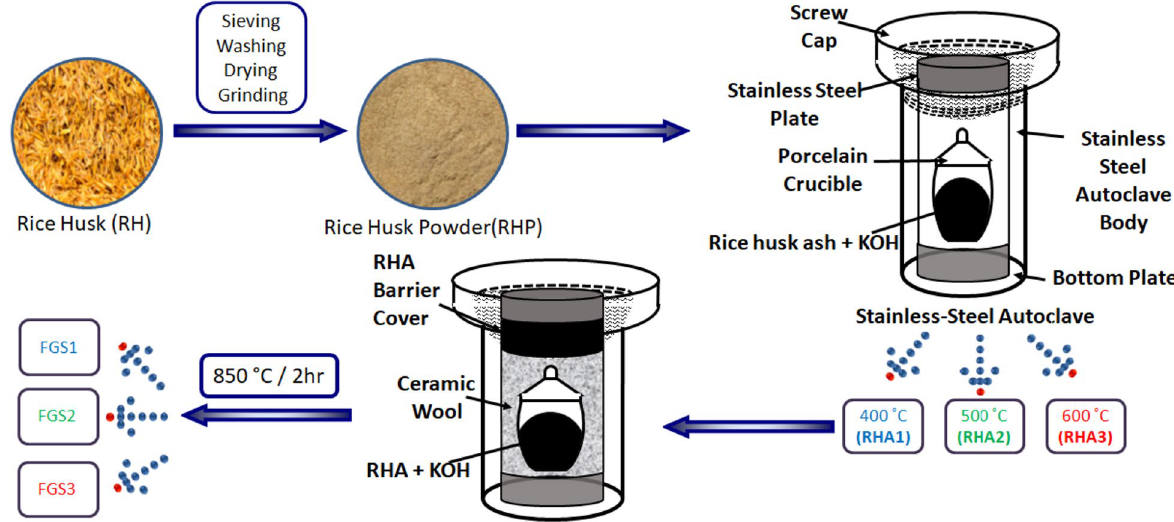
Figure 1. Schematic representation set up system for the synthesis of GO/SiO 2